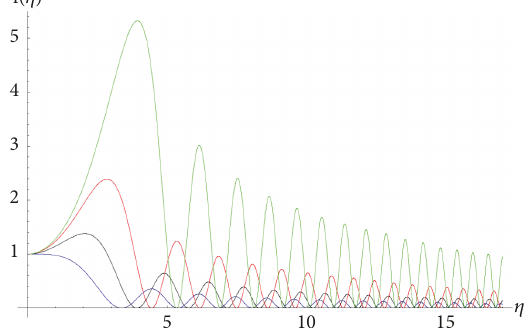
Figure 1: Various shape functions of the density. The blue curve is the analytic solution of equation (7) with 𝑛 = 0 nonlinearity parameter. Black, red, and green functions are numerical results of equation (10) for 𝑛 = 0.078,0.11 and 0.13 nonlinearity parameters. (All curves are for the same initial conditions of 𝑓(0) = 1 and 𝑓 󸀠 (0) = 0 .) Note that larger parameters mean larger deviation from the analytic result.